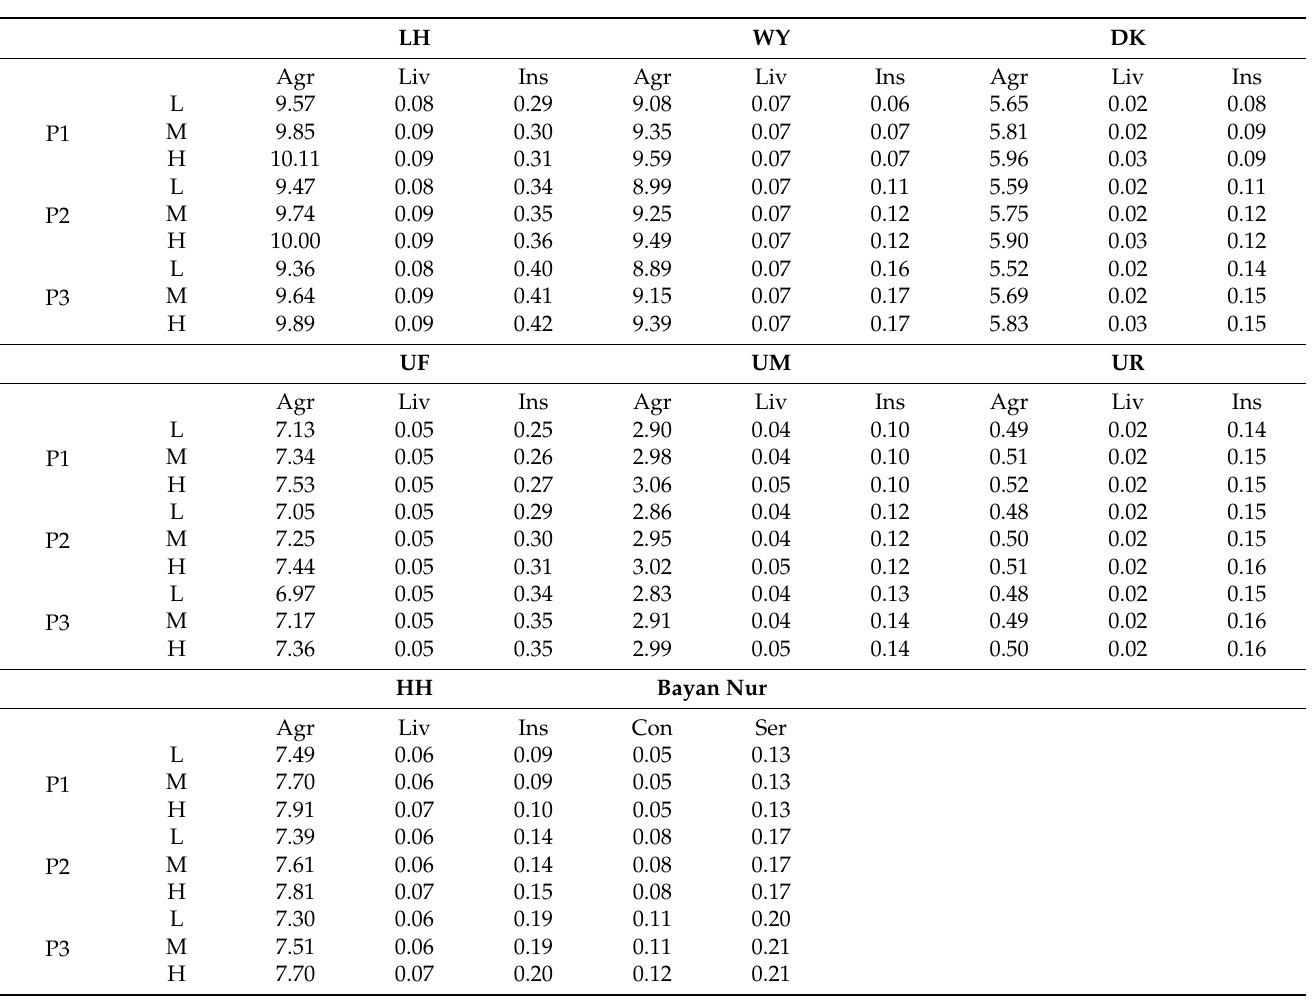
Table 2. Available water resources (10 8 m 3